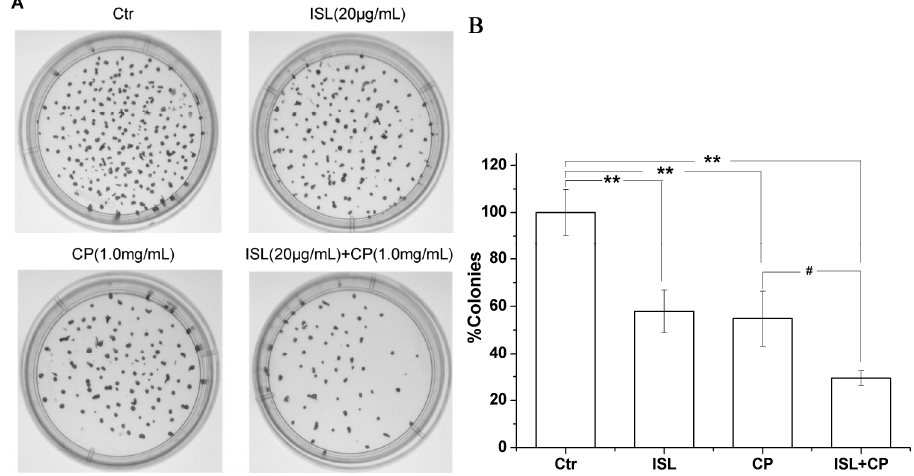
Figure 4, co-treatment with ISL (20 mg/kg) and CP (40 mg/kg) significantly inhibited the growth of cervical cancer U14 cells, the inhibition rate reached 65.66%, while the inhibition rate was 43.55% and 35.57% when treated with ISL(20 mg/kg) or CP (40 mg/kg) alone respectively (Figure 4). Figure 3. Effects of ISL, CP alone or their combination (ISL + CP) on the clonogenic potential in U14 cells. U14 cells were treated with ISL (20 μ g/mL) or CP (1.0 mg/mL) alone or with their combination and allowed to proliferate for eight days. ( A ) Representative images of colony forming assays. ( B ) Colonies were counted and expressed as a percent of the control. Data are presented as mean ± S.D. from three independent experiments.